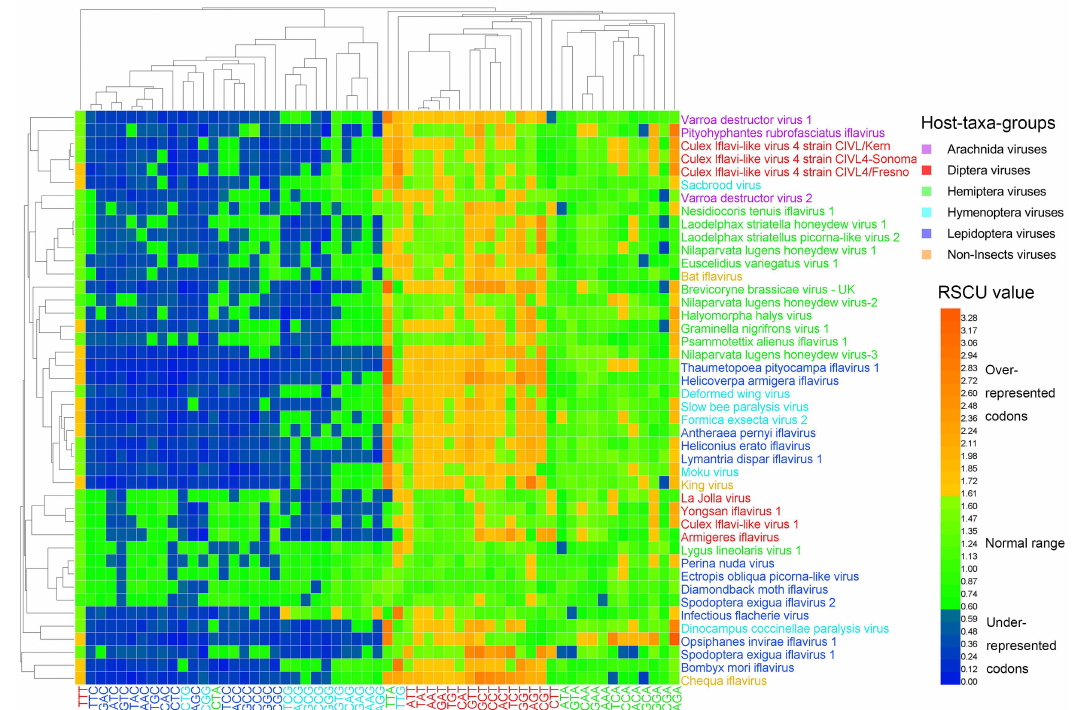
Figure 3. Heat map of the relative synonymous codon usage (RSCU). Iflavirus genomes were clustered in accordance partially with the viral host taxa, and codons were clustered in accordance mainly with the third base, indicating that viral host taxa impact codon usage, and the codon usage is highly biased toward T-ending codons. The viruses and codons were clustered by the Average Linkage method using the Euclidean